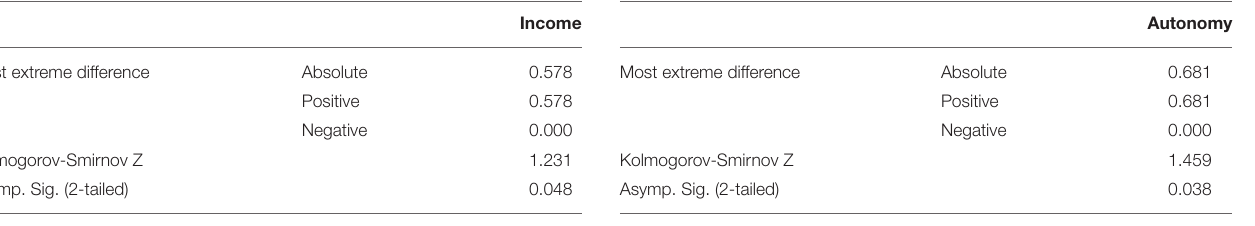
TABLE 2 | Kolmogorov–Smirnov (K-S) test results of the index “income”.